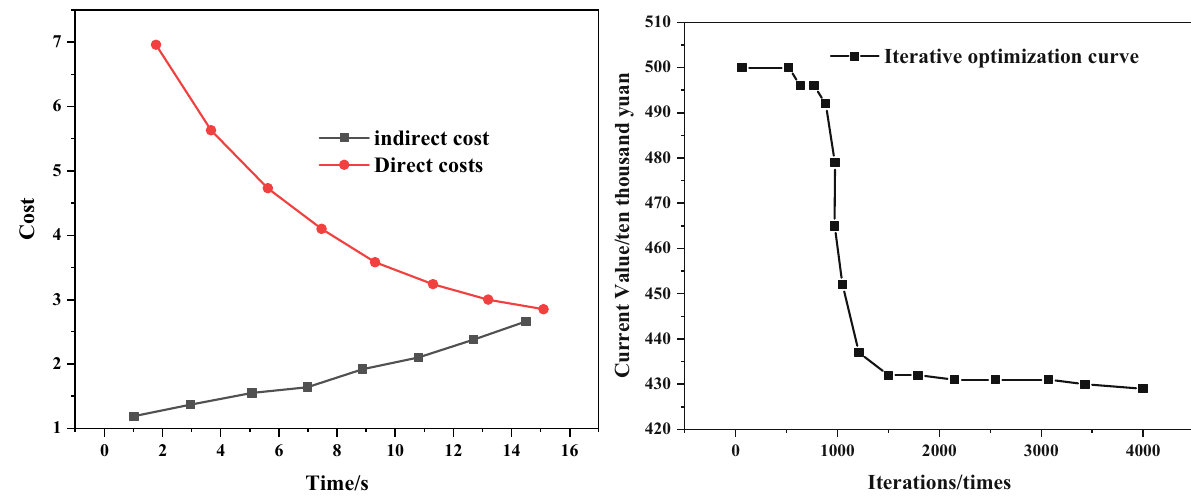
Figure 5: Iterative optimization